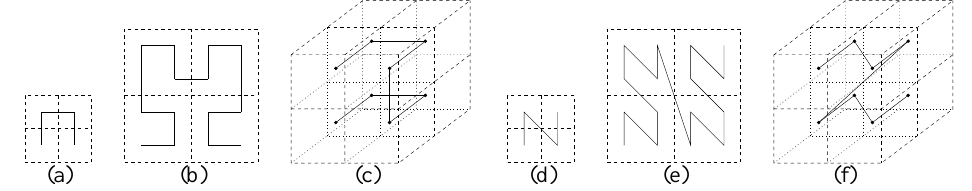
Fig. 1: Recursive constructions of Hilbert and z-order curves of higher order ( H m necting symmetric (via reflection and rotation) subcurves of lower order ( H m H 2 ; (c) H 3 ; (d) Z 2 ; (e) Z 2 ; (f) Z 3 2 1 2 1 1